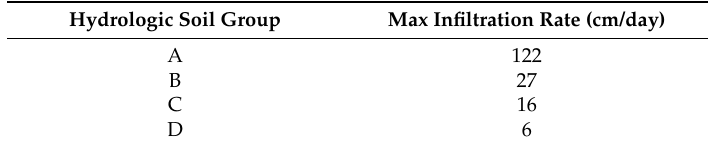
Table 5. Maximum Infiltration